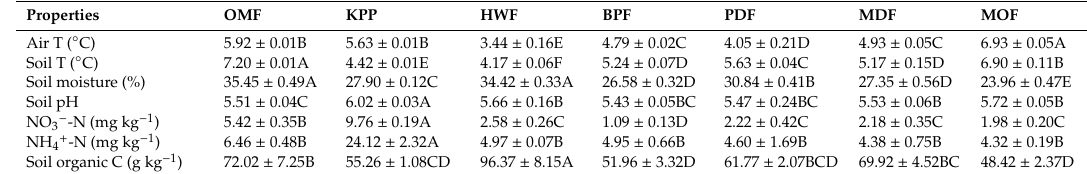
Table 2. Physico-chemical properties of experimental sites. Data are expressed as mean ± SE, n = 12. Properties OMF KPP HWF BPF PDF